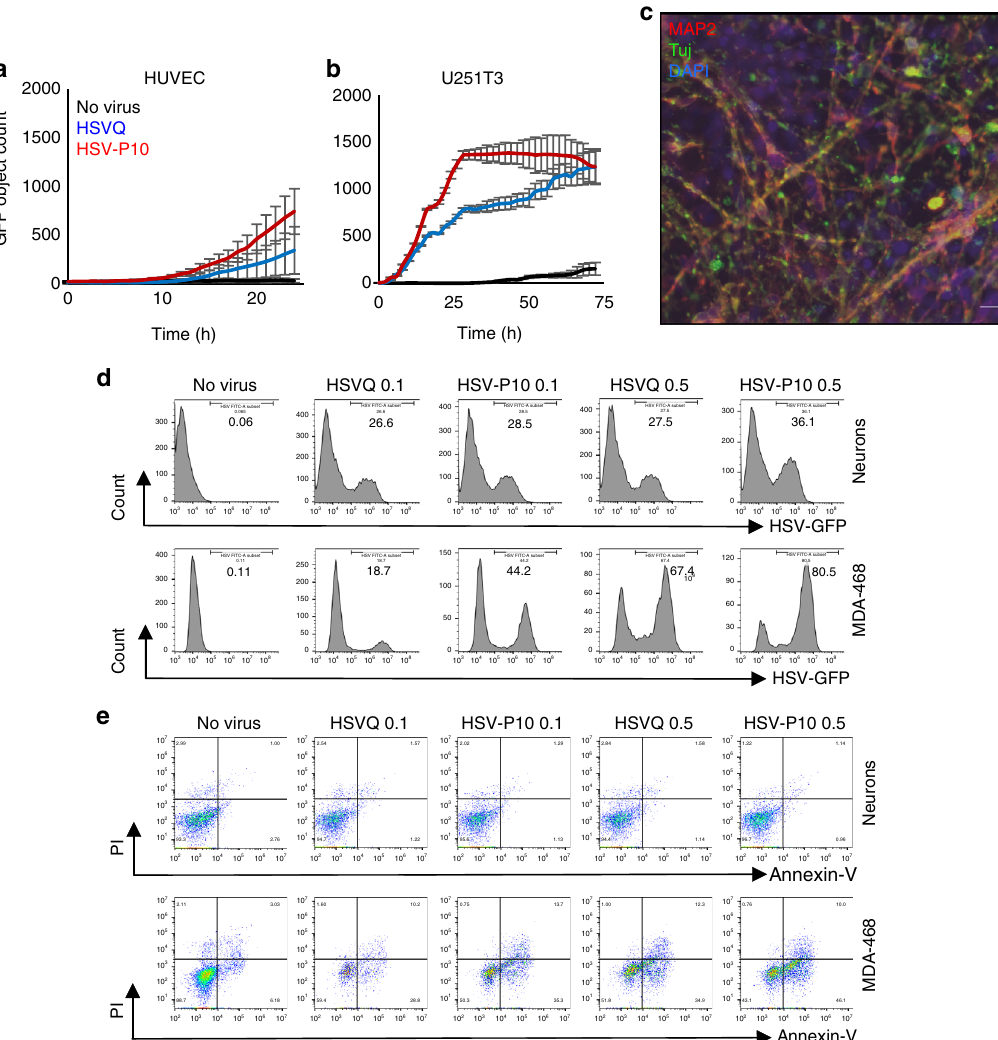
Fig. 5 Safety of HSV-P10. Viral spread of HSVQ (blue line) and HSV-P10 (red line) in cultures of HUVEC ( a ) and U251T3 tumor cells ( b ) was assessed using the Cytation 5 live imaging system, where GFP expression was monitored over time. GFP object count was quanti fi ed and graphed as an average of 4 wells per treatment group ± SEM. c Immuno fl uorescent staining of differentiated neurons showing MAP2 and Tuj1 staining. Scale bar = 50 µ m. d Infection (GFP) of neurons and MDA468 cells followed by GFP visualization. Data shown are histograms of the indicated cells infected with HSVQ or HSV-P10. e Cytolytic activity (PI/Annexin-V) in neurons was assessed by fl ow cytometry 24 hpi. Dot blots of annexin and PI staining of infected (GFP positive) neurons and MDA-468 expression on these cell types, would allow for more robust priming of an antitumor T-cell response. To test our hypothesis that T-cells were primarily responsible for the long-term survival bene fi t of HSV-P10 treatment, we evaluated the therapeutic bene fi t of HSV-P10 in mice depleted of CD4 + or CD8 + T-cells using intraperitoneal injections of anti-CD4 or anti-CD8 deplet- ing antibodies (Fig. 9a). Antibody mediated depletion of speci fi c T-cell subtypes was con fi rmed by fl ow cytometric analysis of splenocytes of mice treated with either anti-CD4 or anti-CD8 depleting antibodies (Fig. 9b). While CD4 depletion did not affect overall survival of virally treated mice (Fig. 9c, Supplementary Figure 8a), CD8 depletion signi fi cantly reduced the survival of HSV-P10 treated animals (Fig. 9d, p = 0.0036), but not HSVQ treated (Supplementary Figure 8b, p = 0.3109), indicating the importance of CD8 + T-cells in the ef fi cacy of HSV-P10 treat- ment. T-cell depletion did not affect overall survival of saline or HSVQ treated mice (Supplementary Figure 8c). All mice treated with HSVQ or HSV-P10 with CD8 depletion succumbed to